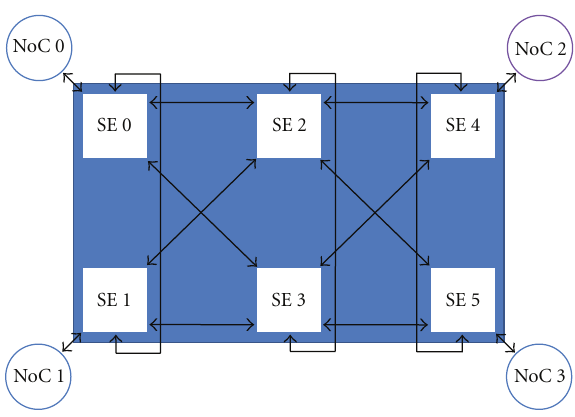
Figure 7: The initial architectural NiP model using HXN.